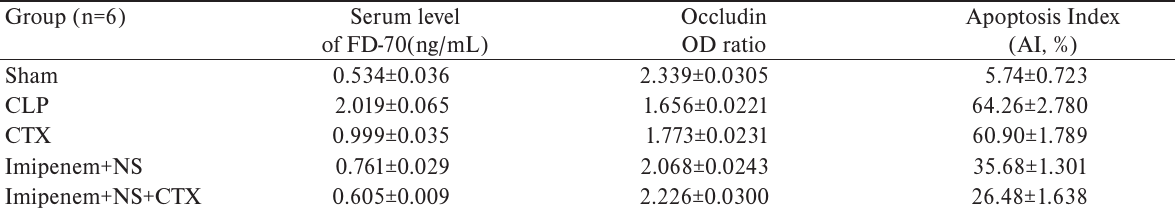
Table 2. Level of serum FD-70 and the number of apoptosis